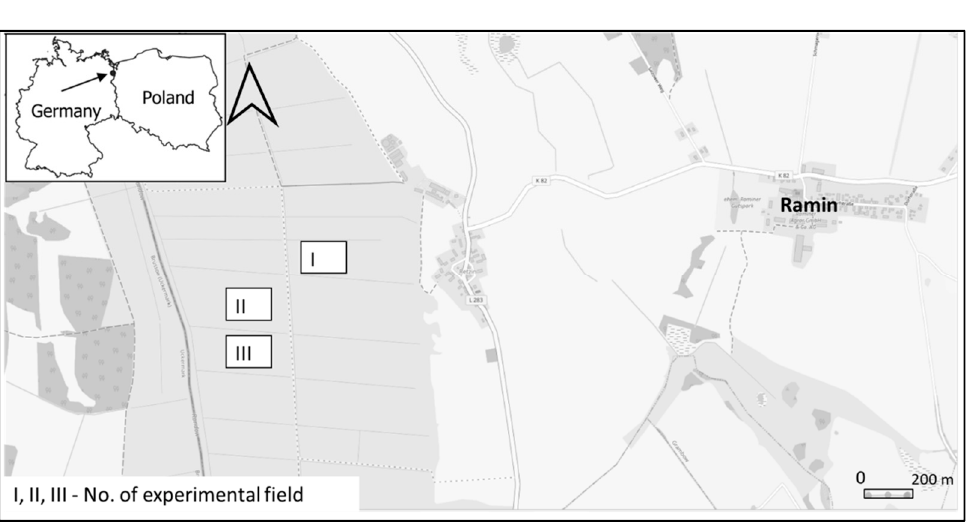
Figure 1. Location of field experiments, geographic coordinates: I—14.252689, 53.409775; II— 14.245987, 53.408330; III—14.246842,